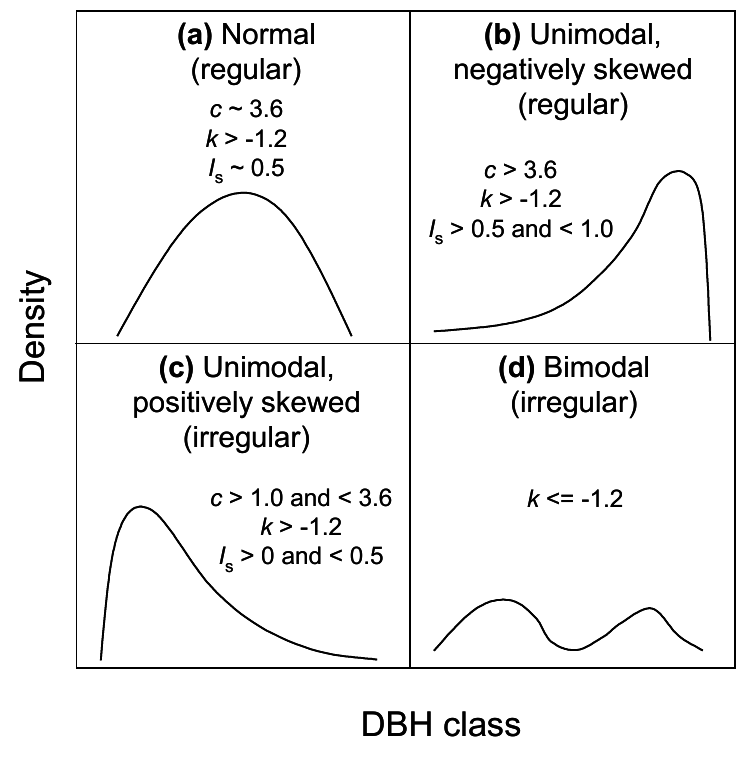
Figure 2. Theoretical diameter distributions and respective statistical thresholds as defined by the Weibull function ( c ), kurtosis ( k ) and the symmetry index ( I s ): ( a ) normal, regular; ( b ) unimodal, negatively skewed, regular; ( c ) unimodal, positively skewed, irregular; ( d ) bimodal,